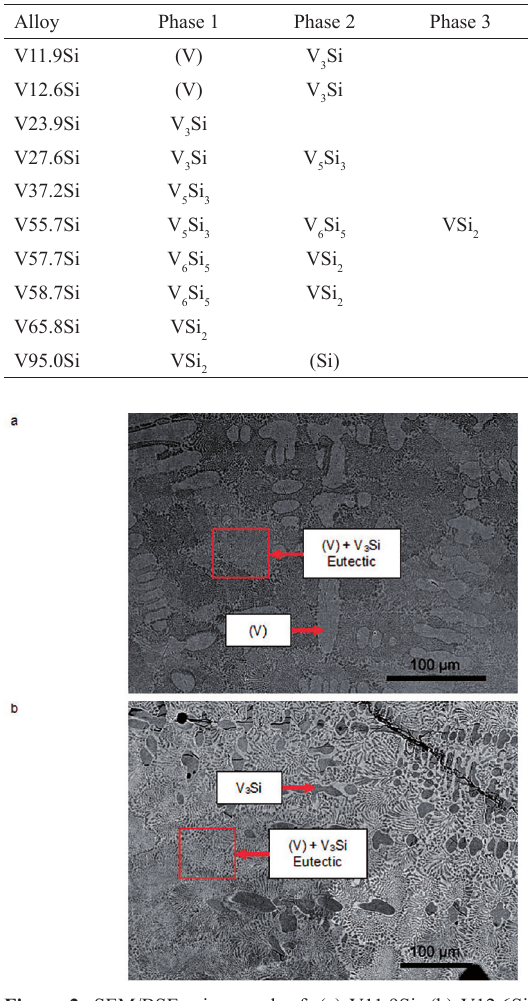
Figure 2: SEM/BSE micrograph of: (a) V11.9Si; (b) V12.6Si as-cast alloys.